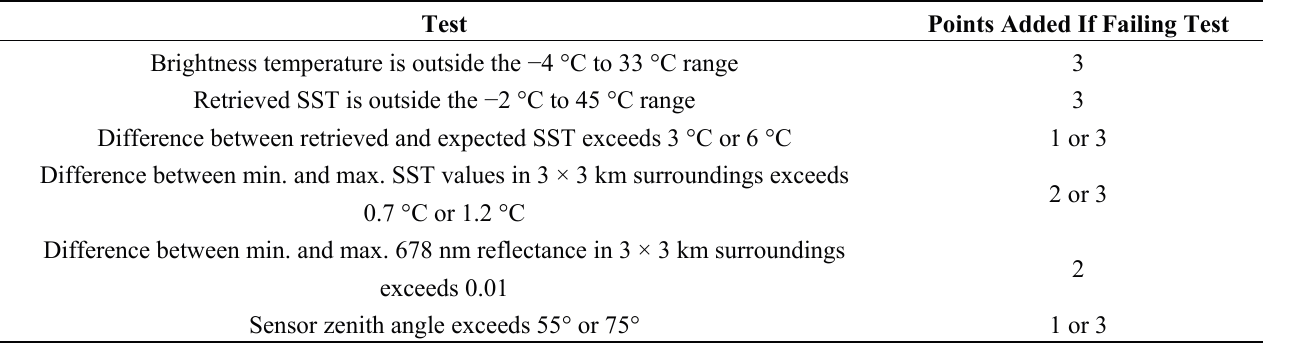
Table 1. List of the tests considered by the operational MODerate resolution Imaging Spectroradiometer (MODIS) ocean color data processing for setting the sstwarn flag. The flag is set if the total number of warning points is 1, 2, or 3. (Pixels with more warning points are flagged by the sstfail flag and are not used.) A detailed description of sstwarn flag is at http://oceancolor.gsfc.nasa.gov/DOCS/modis_sst/. Test Points Added If Failing Test Brightness temperature is outside the − 4 °C to 33 °C range 3 Retrieved SST is outside the − 2 °C to 45 °C range 3 Difference between retrieved and expected SST exceeds 3 °C or 6 °C 1 or 3 Difference between min. and max. SST values in 3 × 3 km surroundings exceeds 2 or 3 0.7 °C or 1.2 °C Difference between min. and max. 678 nm reflectance in 3 × 3 km surroundings 2 exceeds 0.01 Sensor zenith angle exceeds 55° or 75° 1 or